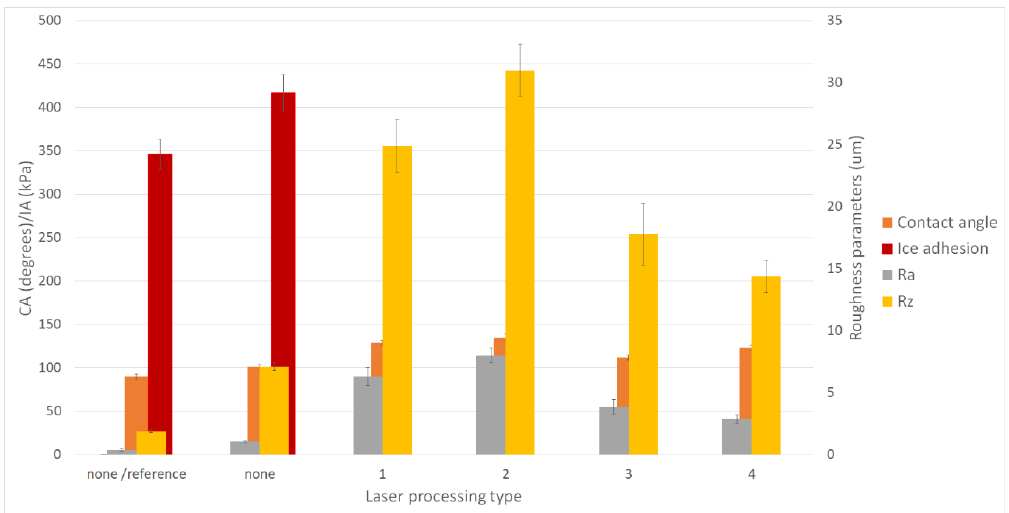
Figure 10. Characteristics of samples with SILOX2 5 wt.% chemical modifier.